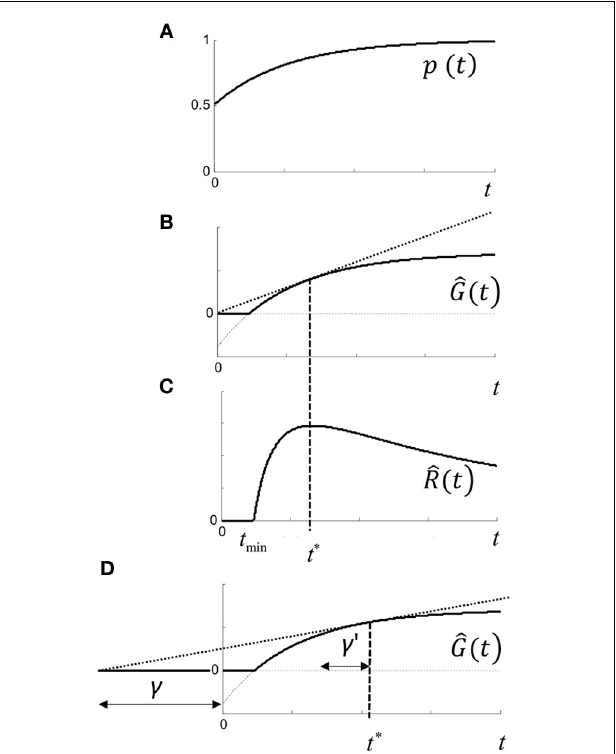
FIGURE 11 | Rate model. (A) p ( t ) is subjective probability of being correct given a response is made at time t, and is assumed to be concave. Initial value of p ( t ) assumes guessing with no prior information, and final value is assumes that response will be correct given infinite time. (B) ˆ G ( t ) is the expected gain in utility (Equation 1.4) for a response made at time t . Note that gain may be negative (i.e., loss) for t < t min (dashed curve) and no response is optimal. (C) ˆ R ( t ) is the expected rate of gain in utility (Equation 1.5) which has a maximum at t ∗ , and can be visualized geometrically as the point where the tangent touches ˆ G ( t ) in (B , D) shifting the time origin back by γ increases t ∗ by γ (cid:12) (see text).